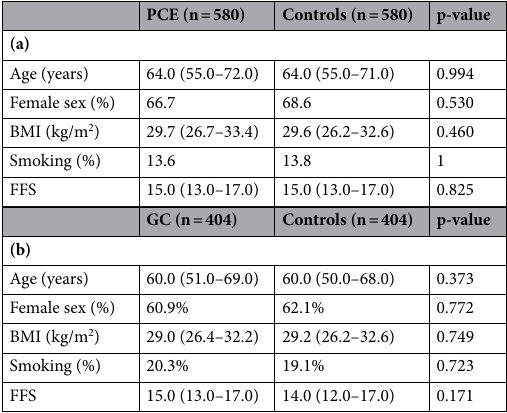
Table 1. Phenotype characteristics of individuals post-cholecystectomy, gallstone carriers, and controls. Age, BMI and FFS are given as median (1st–3rd quartile). Female sex and smoking are stated as percentages. All numbers were rounded to one decimal place. BMI body mass index, FFS food frequency score, GC gallstone carriers, PCE individuals post-cholecystectomy, n number of cases. Statistical significance was assessed by Mann–Whitney test or Fisher’s exact test for continuous or binary variables,